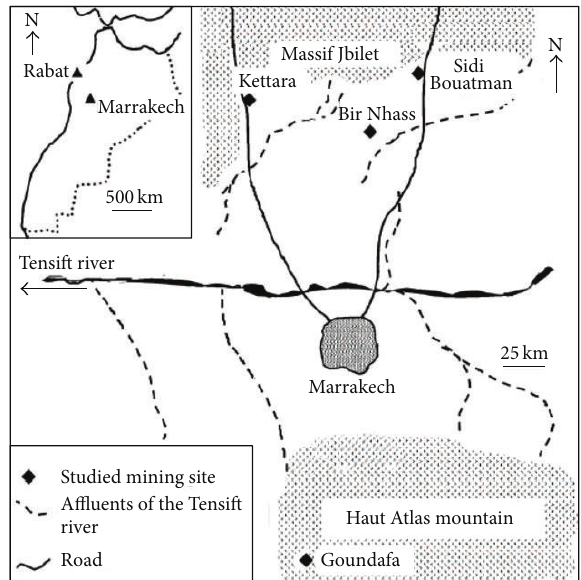
Figure 1: Localisation of prospected abandoned mining areas of Marrakech, Morocco: Kettara, Sidi bouatman, Bir Nhass, and